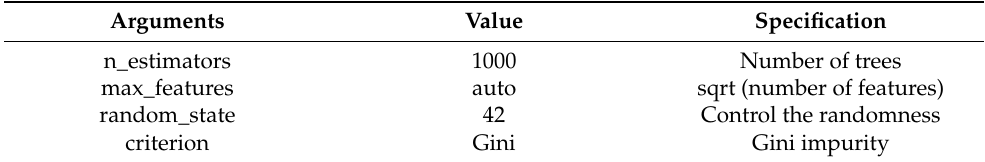
Table 7. Random Forest Model Specifications.